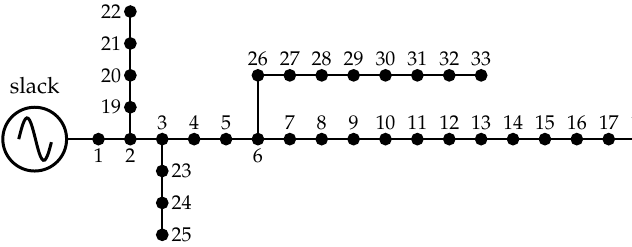
Figure 1. Schematic connection between nodes in the 33-nodes test